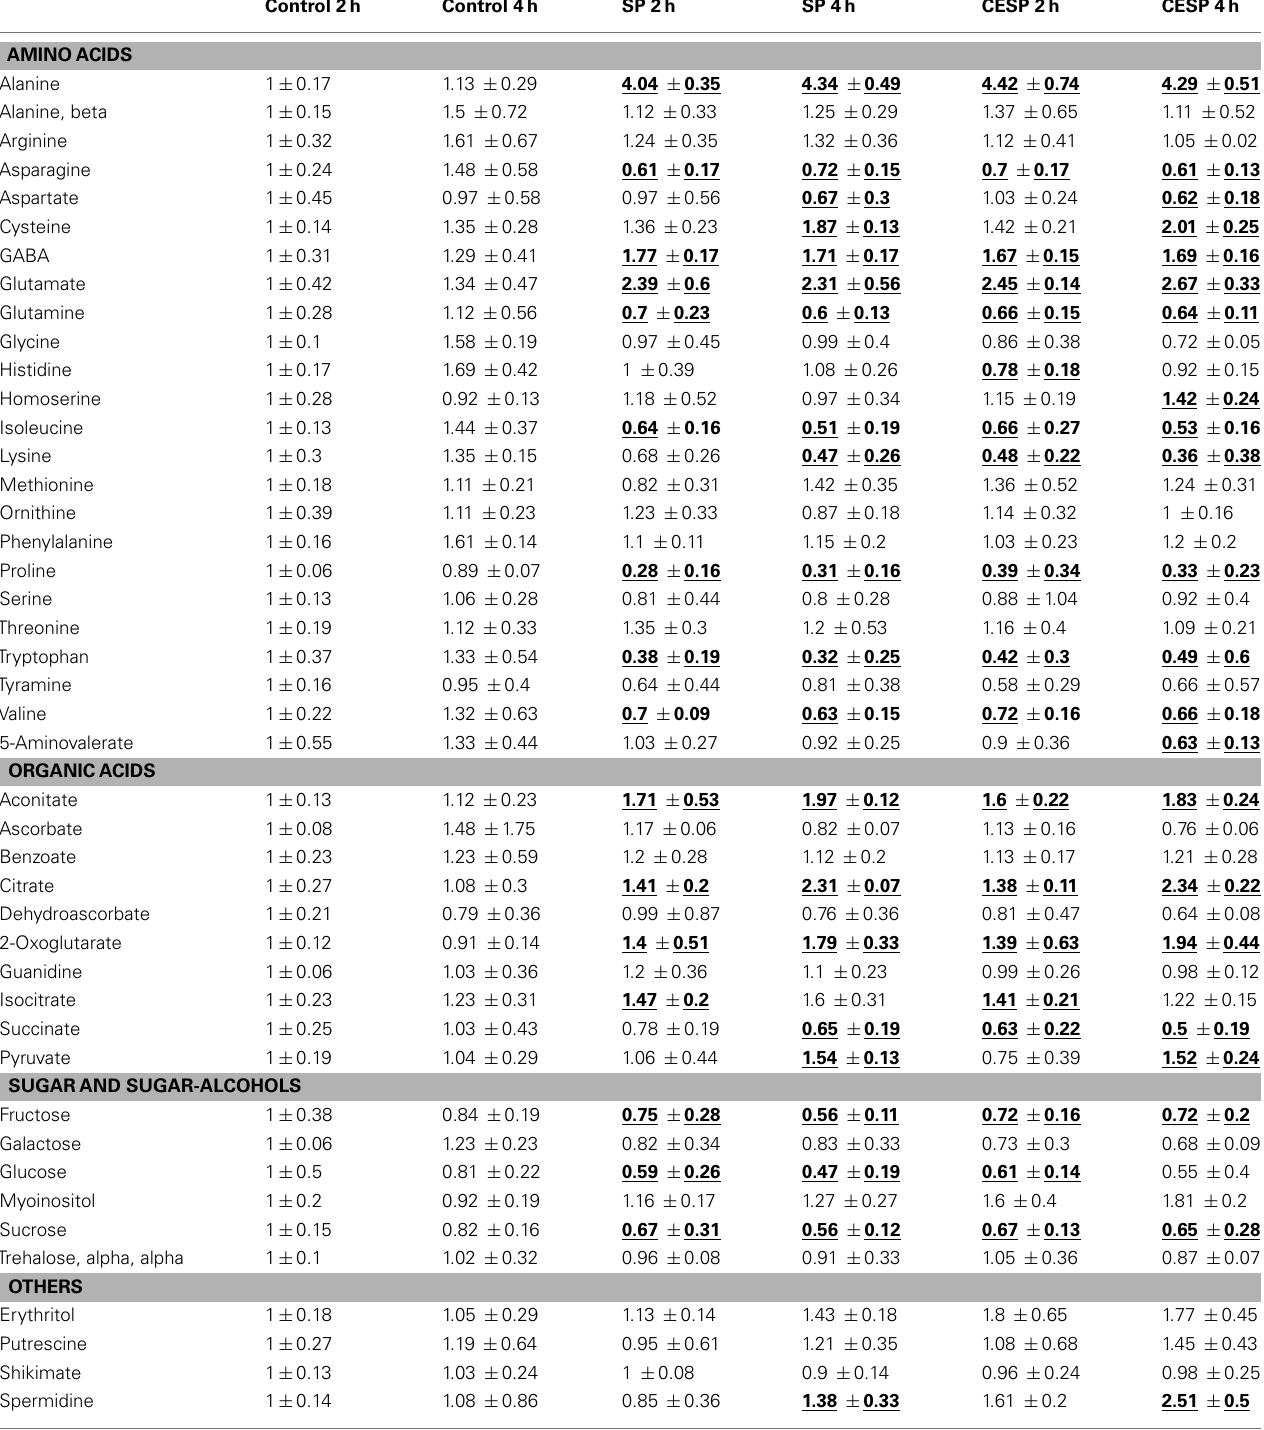
TableA1 | Relative metabolite content of treated and control Arabidopsis leaf